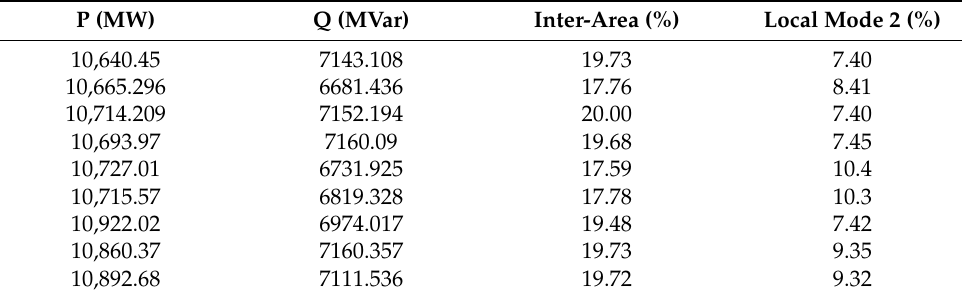
Table 8. Damping value of critical EM modes under different operating conditions.